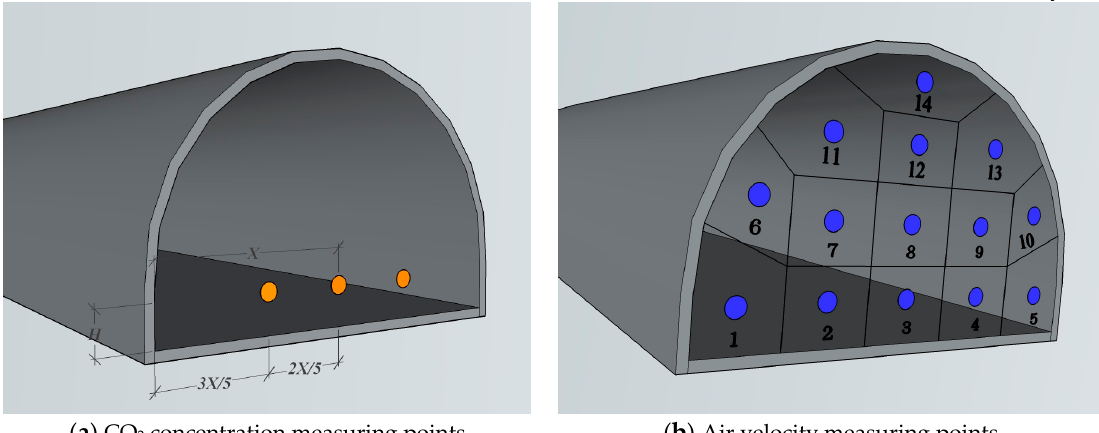
Figure 11. Arrangement of measuring points.